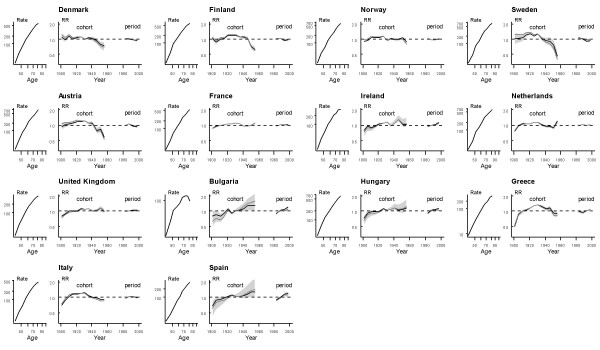
Age, period, and cohort effects on kidney cancer mortality for European men. Age effects are expressed as rates per 1,000,000 person-years, and period and cohort effects as rate ratios (RR) with respect to their average. Osmond-Gardner (black lines) and Decarli-La Vecchia solutions (grey lines) were used to estimate period and cohort effects. The shaded areas are determined by curvatures and exclusive cohort or period slopes. See Methods for further details.